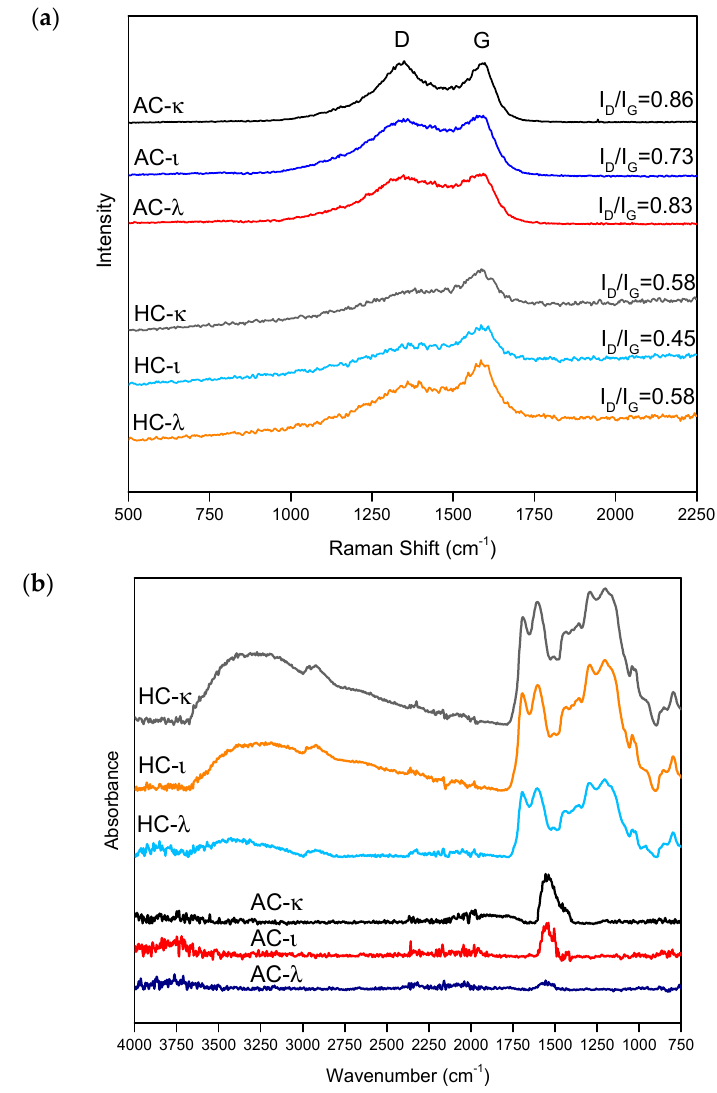
Figure 4. Raman ( a ) and ATR-FTIR ( b ) spectra of hydrochars (HC) and activated (AC) carbons. The chemical identity of the carbon materials before and after activation was assessed by ATR- FTIR spectroscopy (Figure 4b) and the most relevant bands were assigned as depicted in Table S1 (Supporting information). All hydrochars exhibited a broad band at 3000–3600 cm − 1 that is ascribed to O-H stretching vibrations from surface hydroxyl groups and adsorbed water molecules. The bands at 2929 and 2879 cm − 1 confirm the presence of aliphatic carbons, –CH 2 - and –CH 3 [48]. The overlapping bands with peaks at 1695 cm − 1 and 1606 cm − 1 are due to carbonyl (C=O) stretching vibrations and the stretching of C=C in aromatic rings, respectively [49]. The broad band at 1298 cm − 1 is ascribed to C-O bending vibrations [50]. The band at 798 cm − 1 is attributed to the C-H vibration in aromatic structures